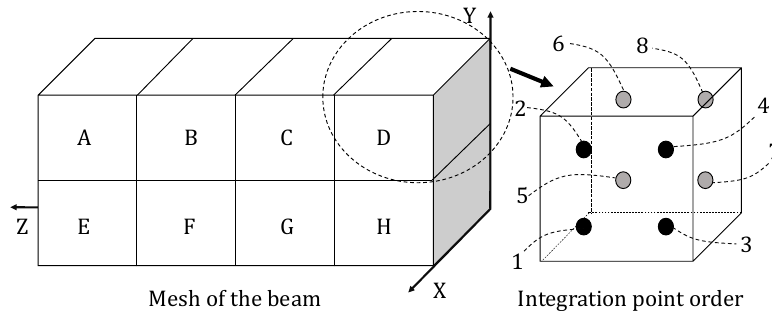
(a) Figure 13. Geometry and boundary conditions for the three-point bending beam.